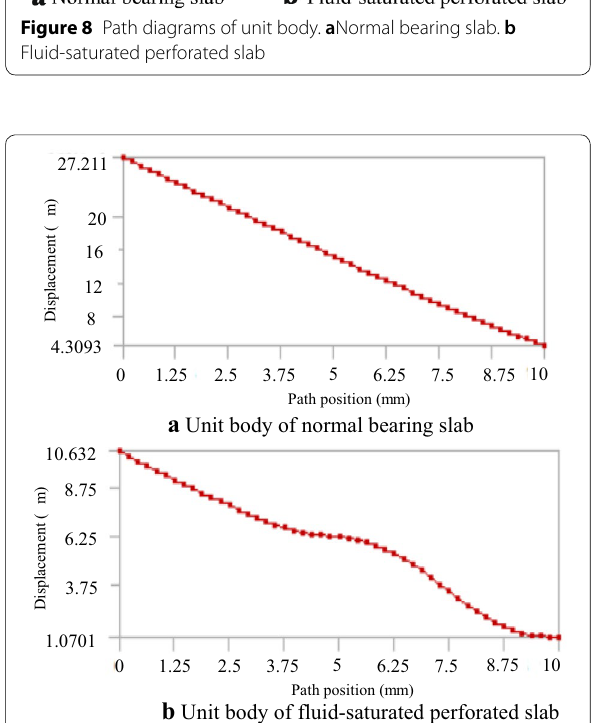
Figure 9 Transient response along the path a Unit body of normal bearing slab b Unit body of fluid-saturated perforated slab